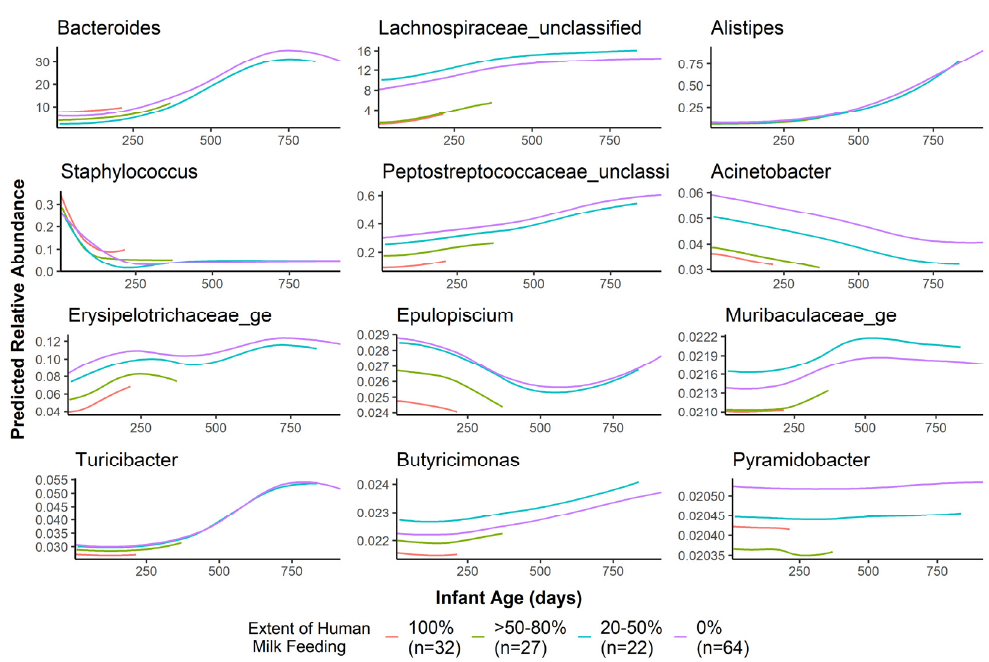
Figure 4. Genera relative abundance as predicted by age and human milk in the infant diet. Only those genera significantly predicted by age and human milk intake are plotted.